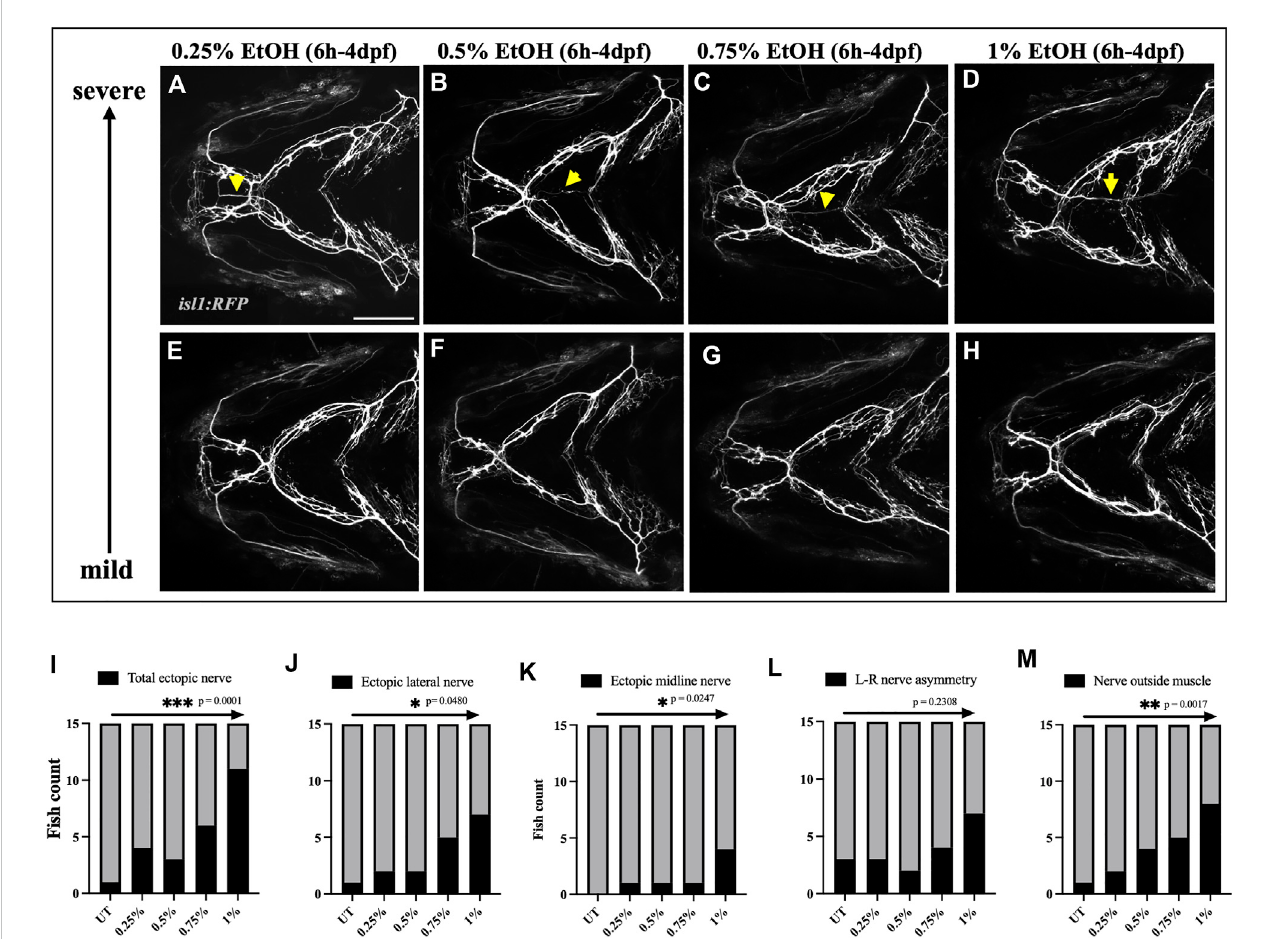
FIGURE 6 Prevalence of ectopic cranial nerve defects increases in a dose-dependent manner (A – D) Representative images of most severe cranial nerve defects in isl1:RFP fi sh exposed to 0.25%, 0.5%, 0.75% % 1% ethanol between 6hpf-4dpf ( n = 15 in each group). Arrows indicate ectopic nerves. (E – H) Representative images of fi sh with mild cranial nerve defects in 0.25%, 0.5%, 0.75% % 1% ethanol-exposed groups. (I – M) Chi-square test for trend shows a linear trend between the number of fi sh with cranial nerve defects and the concentration of ethanol. * = p < 0.05; ** = p < 0.01; *** = p < 0.001. Scale bar = 100